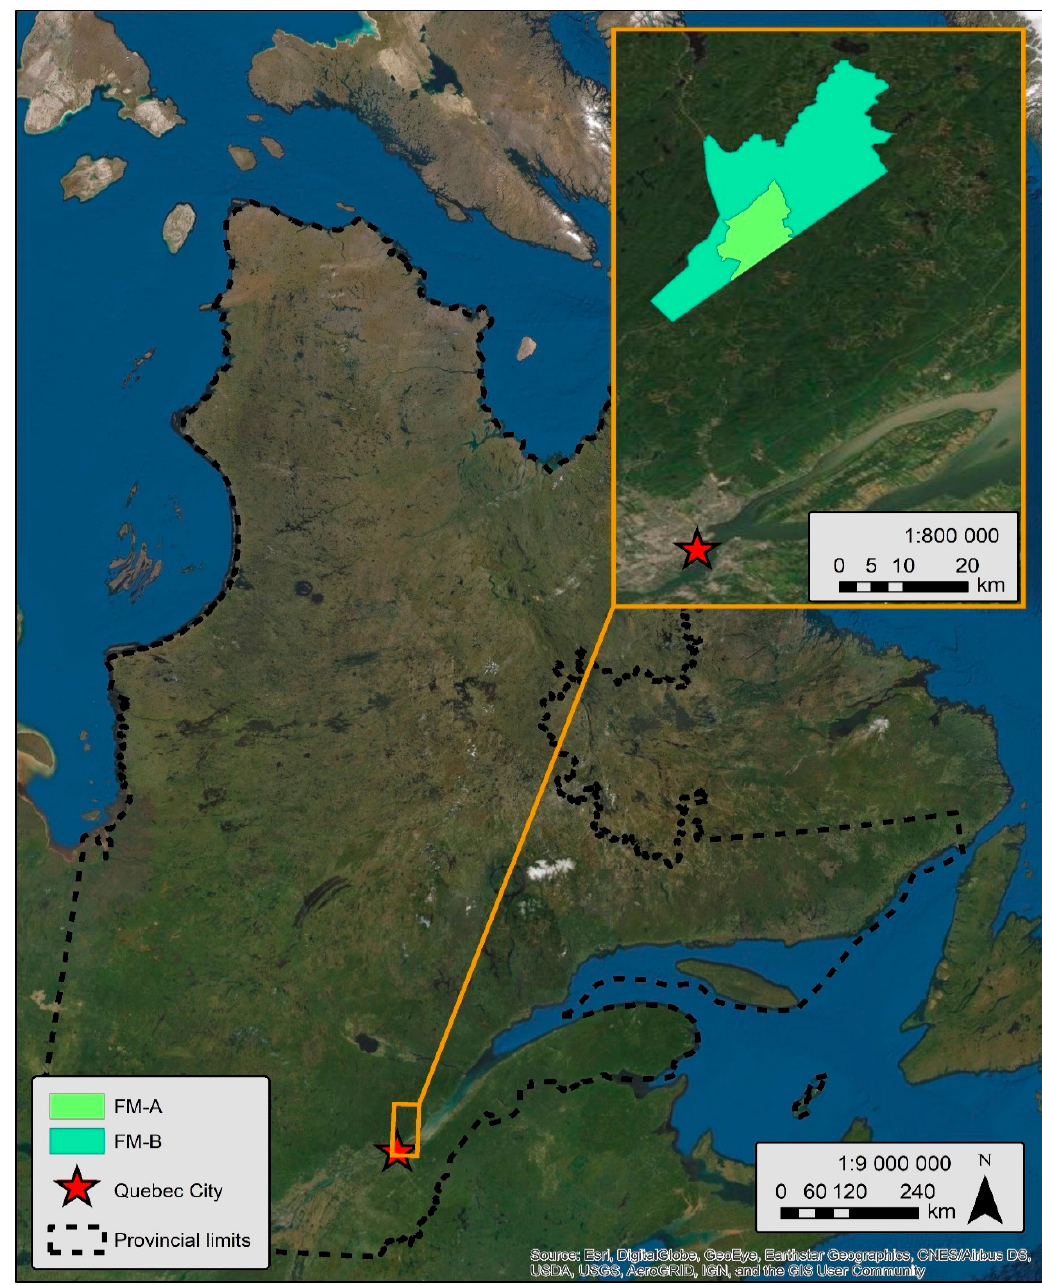
Figure A1. Montmorency Forest localization.